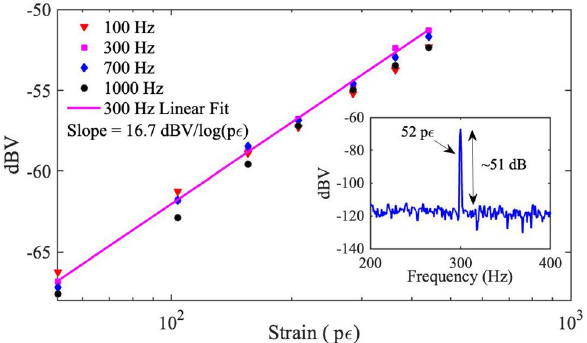
Figure 3. Measured MZ-FP responses under harmonic strain modulations of various amplitudes at 100 Hz, 300 Hz, 700 Hz and 1 kHz. Linear fit and slope are given for data at 300 Hz. Inset: The interferometer output due to a 51 dB. 52- p ε signal displays a signal-to-noise ratio of ∼